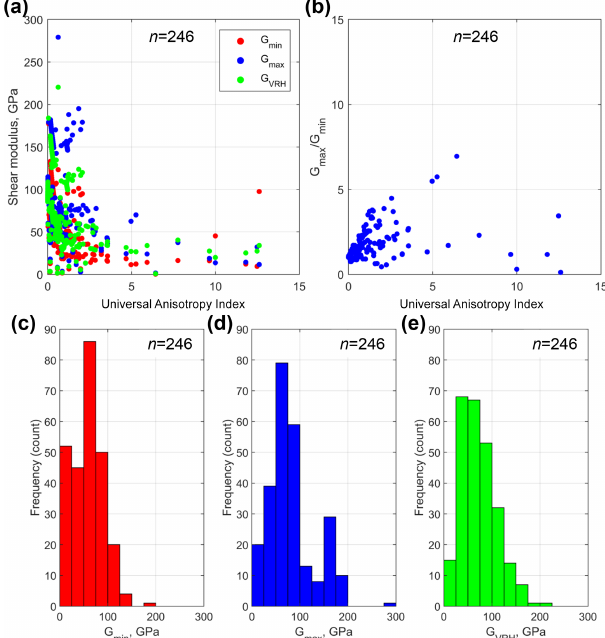
Figure 10. Anisotropy of Young’s modulus in rock-forming miner- als ( n = 246) plotted against the Universal Anisotropy Index ( A U ) of Ranganathan and Ostoja-Starzewski (2008). E VRH is the Voigt– Reuss–Hill average of E . Many minerals display anisotropy of E ( E max /E min ) of 2 or more. (b) Plot of E max /E min versus A U . (c– e) Histograms of E min , E max and E VRH to show the distribution across all 246 datasets.